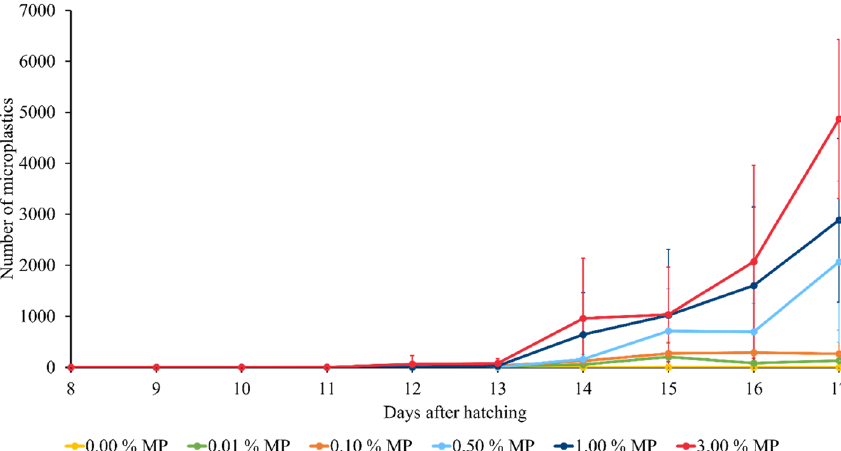
Figure 3. Uptake of microplastics (MP) over time by BSF larvae reared on an artificial food waste stream containing different microplastic contents ( w MP = 0.00, 0.01, 0.10, 0.50, 1.00, 3.00%) of fluorescent blue-labelled polyethylene microplastics ( Dv(50) = 61.5 µm). The results shown are the mean values ( n = 9), while the error bars depict their standard deviations.